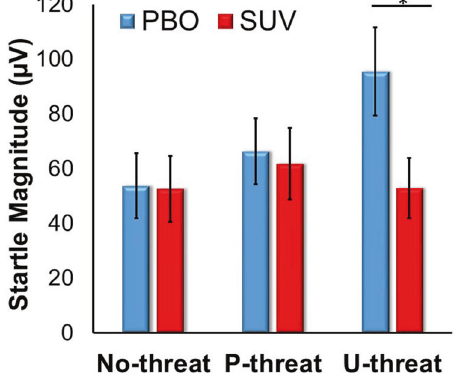
Fig. 1 Bar graph displaying mean startle magnitude during each task condition, across both lab sessions. PBO placebo, SUV 10 mg suvorexant. Bars re fl ect two standard errors. including excessive drowsiness. With regard to blinding, 61.9% successfully reported receiving drug and 85.7% successfully reported receiving placebo.